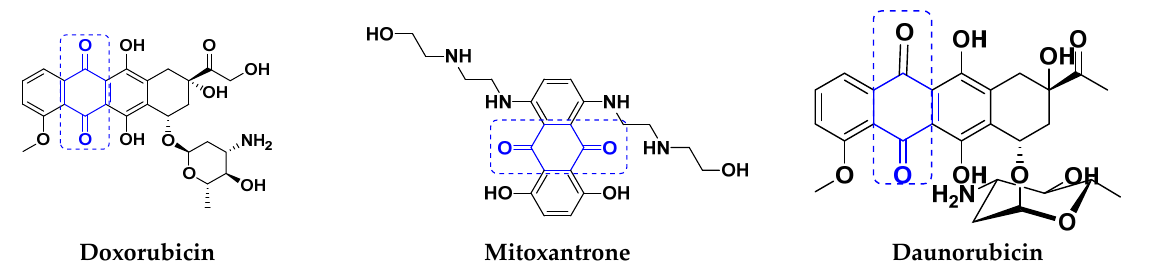
Figure 49. FDA approved drugs with Quinone hybrids.